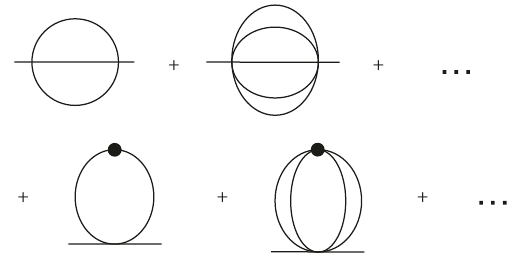
Figure 2: The contributions to the two-point function Γ (2) (𝑝) up to the order of 𝛼 𝑛 𝛼 𝑚